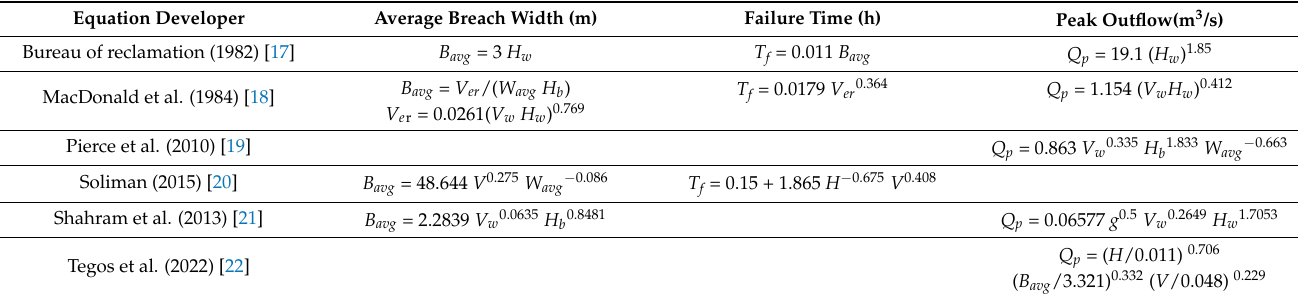
Table 1. Selected empirical equations for dam types, failure modes and erodibilities.